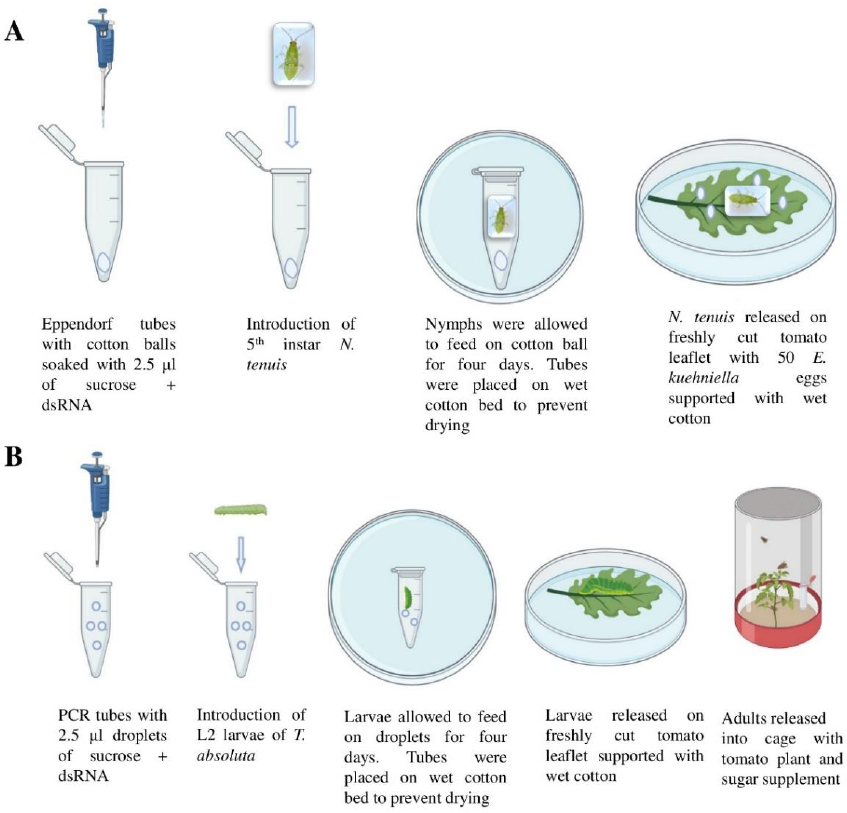
Figure 1. Experimental setup for oral delivery of dsRNA via sucrose. ( A ) For N. tenuis setup, cotton balls were soaked with a solution composed of 0.5 M sucrose + 0.5 μg/μL dsRNA in an Eppendorf balls were soaked with a solution composed of 0.5 M sucrose + 0.5 µ g/ µ L dsRNA in an tube. A single fifth instar nymph was introduced in each Eppendorf tube for 4 d. Three inde-